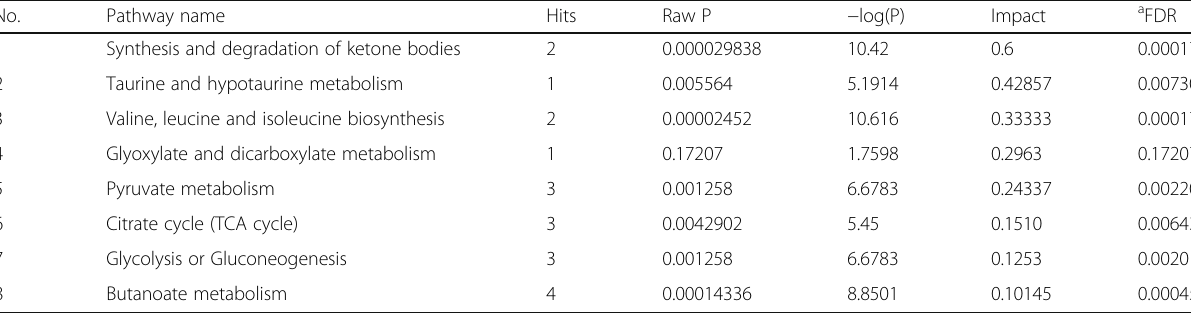
Table 1 Results of ingenuity pathway analysis with MetaboAnalyst (MetPA) No.